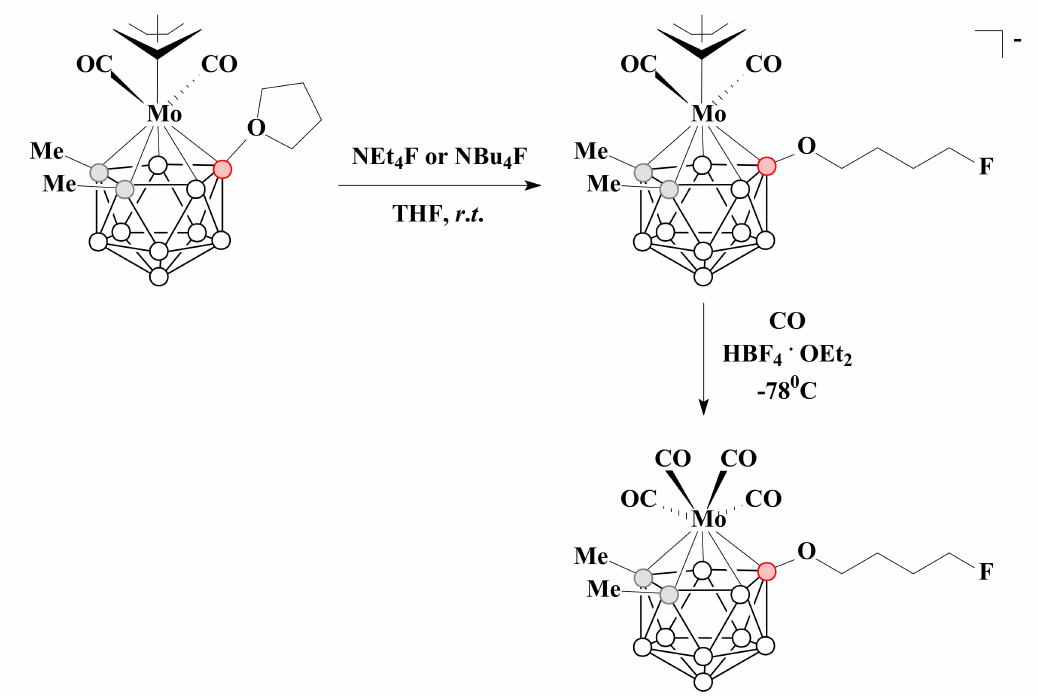
Scheme 28. The synthetic route to [3-( η 3 -C 3 H 5 )-3-(CO) 2 -3-Mo(8-F-CH 2 (CH 2 ) 3 O-1,2-Me 2 -1,2- C 2 B 9 H 8 )] − and [3-(CO) 4 -3-Mo(8-F-CH 2 (CH 2 ) 3 O-1,2-Me 2 -1,2-C 2 B 9 H 8